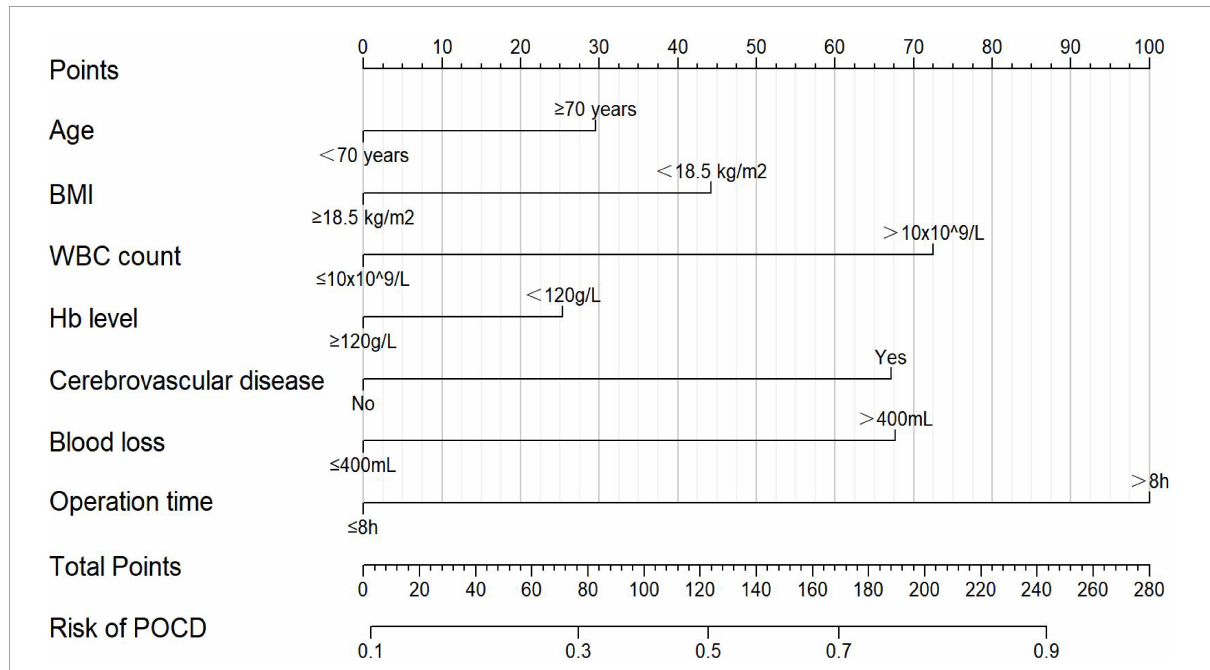
FIGURE2 The nomogram for predicting the probability of POCD in elderly patients after gastrointestinal tumor resection. BMI, body mass index; WBC, white blood cell; Hb, hemoglobin.